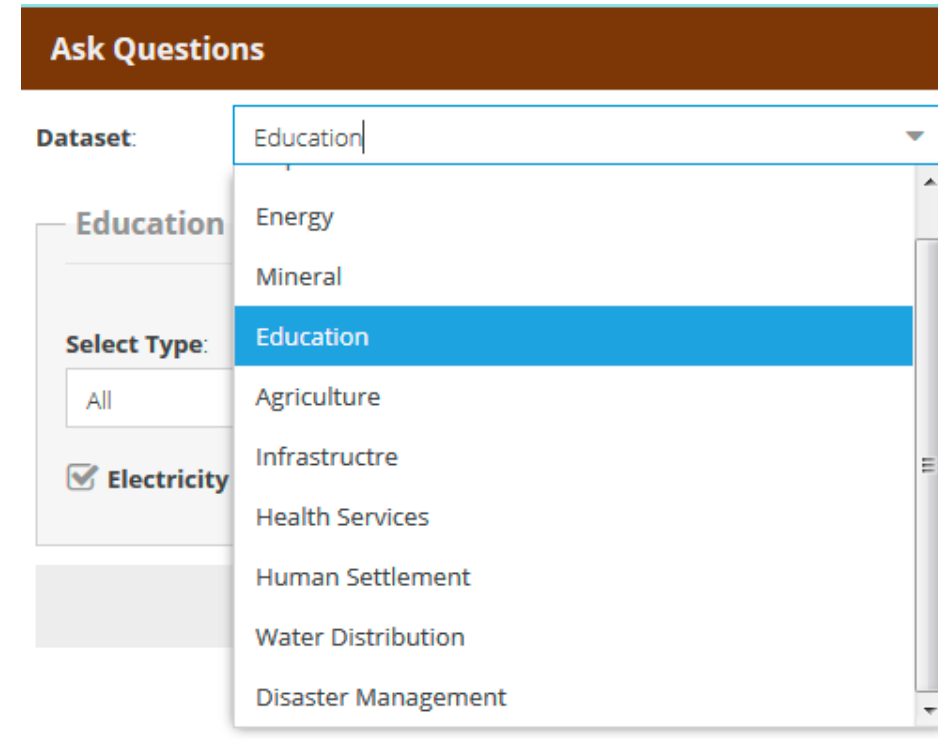
Figure 19. Attribute querying capability.